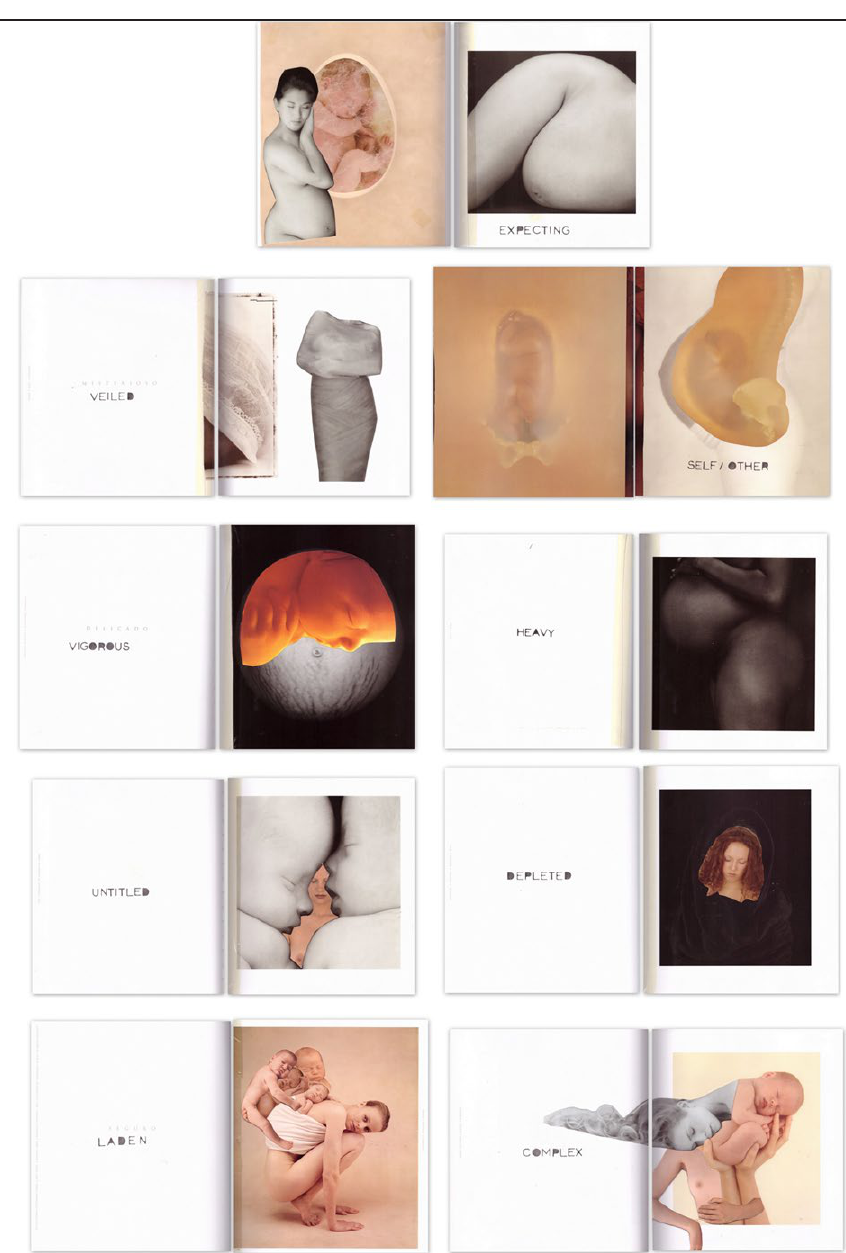
Figure 1: Altered book 1: